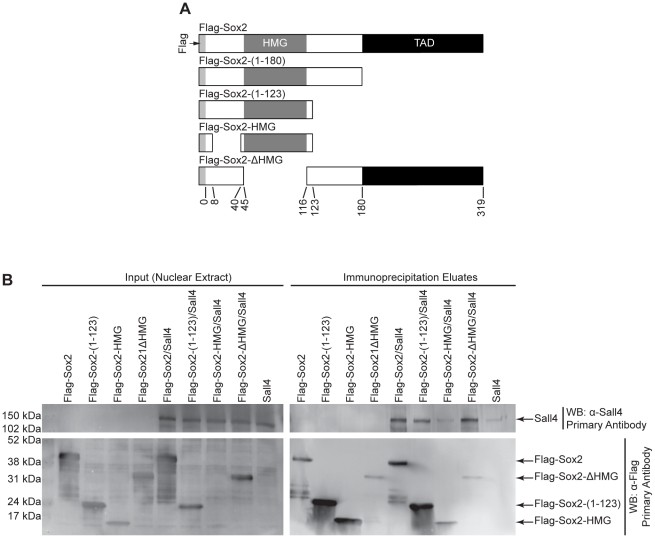
Domains of Sox2 used for association with Sall4.(A) Schematic diagrams of the Flag-Sox2 expression constructs used for domain mapping studies. (B) Mapping domains of Sox2 that mediate its association with Sall4. 293T cells were transiently transfected with an expression construct for Sall4 and the Sox2 constructs shown, and nuclear extracts were prepared 1 day later. Nuclear extracts (input lanes) used for co-immunoprecipitation of Sall4 are presented as western blot analyses, probing for Sall4 (top-left) or the Flag-Sox2 constructs indicated (bottom-left). M2-beads were used to co-immunoprecipitate Flag-Sox2 constructs and their associated proteins. Immunoprecipitate eluates were used in western blot analysis (right panels), and were probed for either Sall4 (top-right) or the Flag-Sox2 constructs (bottom-right). These experiments were repeated, and similar results were observed.